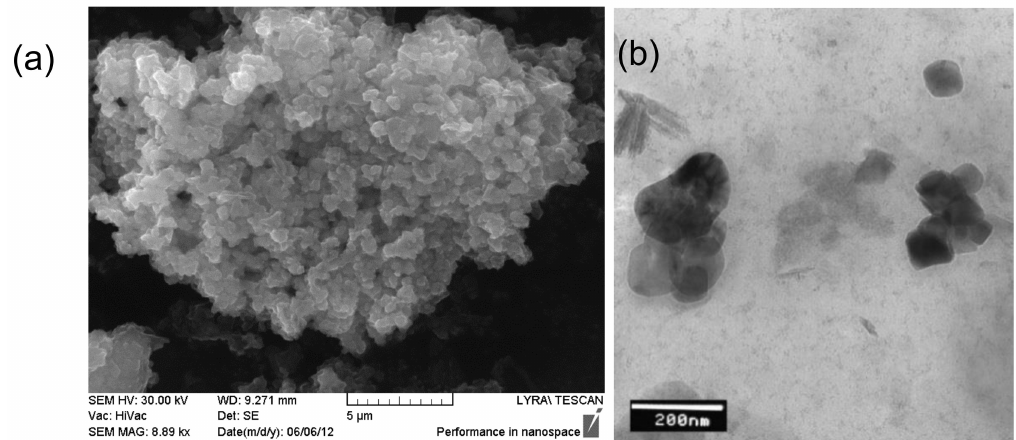
Figure 5. ( a ) SEM image of aggregates and ( b ) TEM image of primary particles forming these aggregates, obtained with 1 wt % Span 80 in heavy oil. The precursor concentration was 1.37 M TiCl 4 .